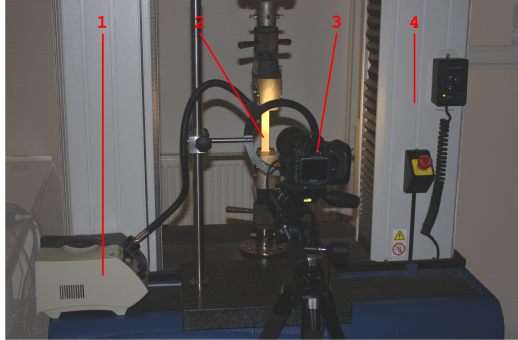
Figure 3. Experimental devices: 1-LED light source, 2-specimen, 3-camera, 4-loading device.